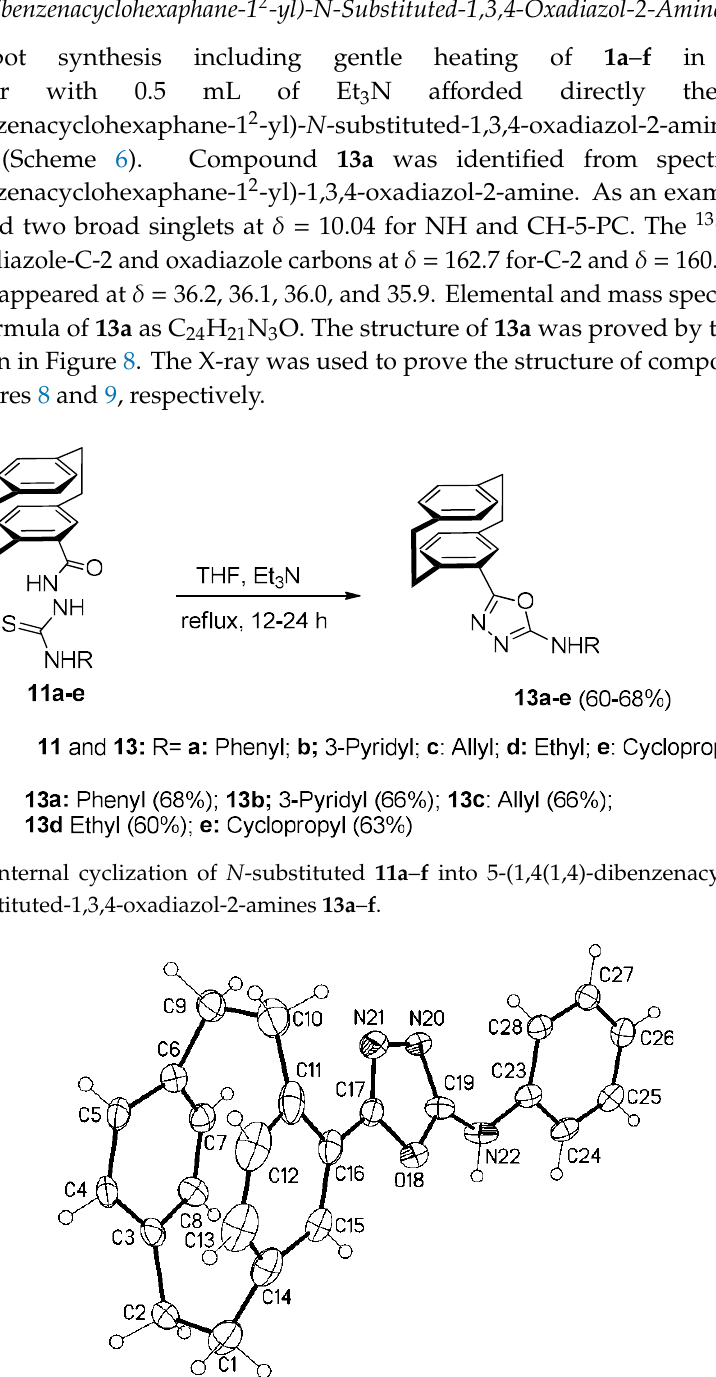
Figure 8. Molecular structure of compound 13a identified according to the IUPAC nomenclature as 5-(1,4(1,4)-dibenzenacyclohexaphane-1 2 -yl)- N -phenyl-1,3,4-oxadiazol-2-amine (displacement parameters are drawn at a 30% probability level).